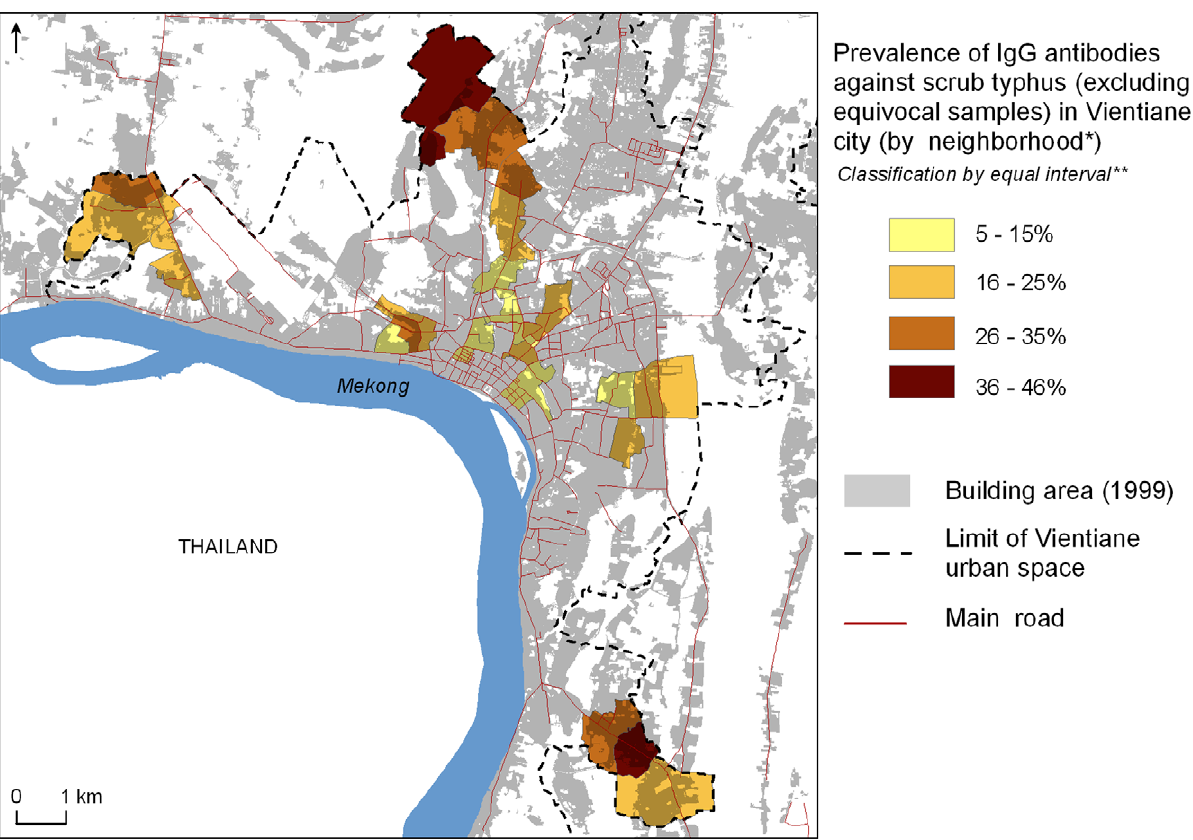
Figure 1. Spatial distribution of households with a member IgG positive against scrub typhus in Vientiane city in 2006. * The « neighborhood » is the primary administrative unit in Laos and constituted the primary sampling unit of the seroprevalence survey within Vientiane. ** Equal Interval Classification method divides a set of attribute values into groups that contain an equal range of values. Note: Cartographic files from ‘‘Atlas Infographique de Vientiane’’ [26].